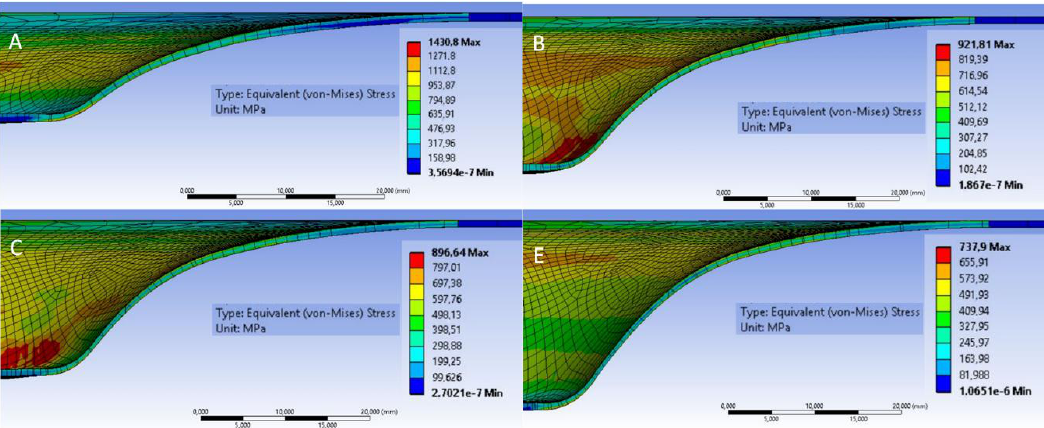
Figure 13. Stress distribution obtained by FEM. ( A ) Room temperature. ( B ) 200 ◦ C. ( C ) 300 ◦ C. ( D ) 400 ◦ C.